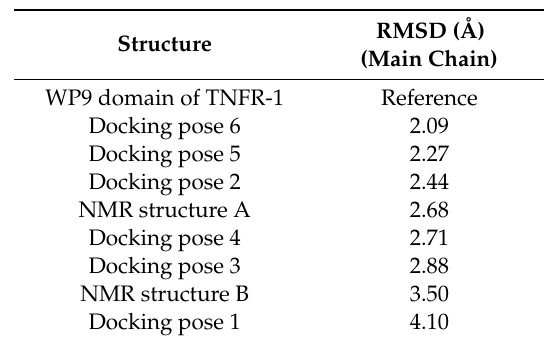
Table 2. RMSDs for aligned and superimposed docking poses and NMR structures of 1 with reference to WP9